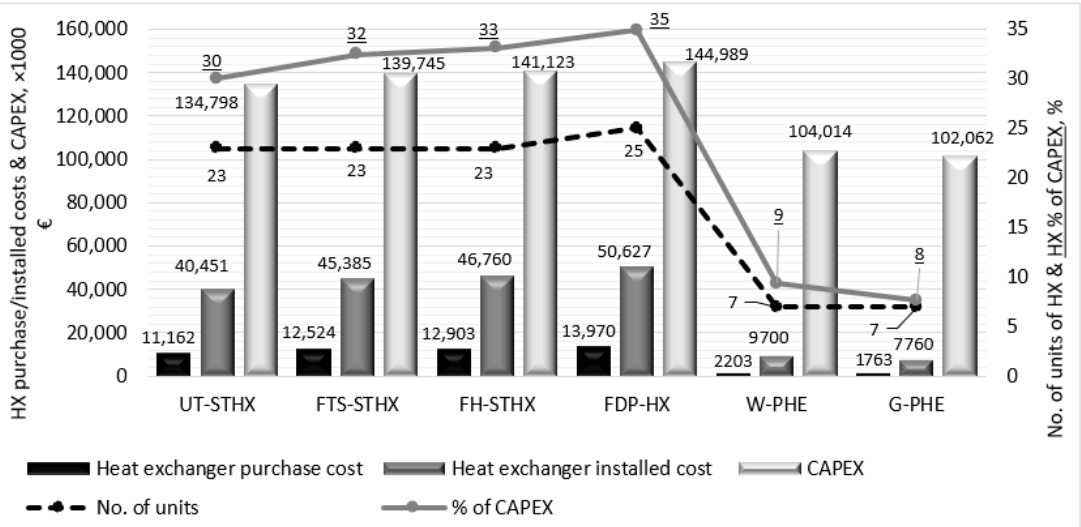
Figure 6. Overview of the number of HX units, HX purchase cost, HX installed costs, CAPEX, and % of HX/CAPEX of the different capture plant options with different HXs [HX stands for heat exchanger].